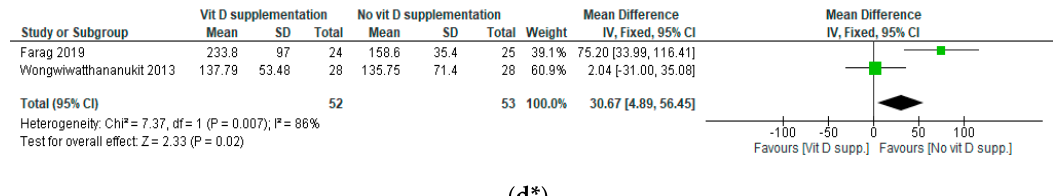
Figure 3. Meta-analysis of effects of low-dose VDS on LDL-C, HDL-C, TC, and TG. Mean differences for each study are represented by squares, and 95% Confidence Intervals are represented by the lines through the squares. The pooled mean differences are represented by diamonds. Between-study heterogeneity was assessed with the use of the I 2 statistic. VDS: Vitamin D Supplementation; LDL-C: Low-density Lipoprotein Cholesterol; HDL-C: High-density Lipoprotein Cholesterol; TC: Total Cholesterol; TG: Triglycerides. ( a ) Forest plot of mean differences in LDL-C (in mg/dL) between subjects receiving low-dose VDS compared with those not receiving VDS. ( b ) Forest plot of mean differences in HDL-C (in mg/dL) between subjects receiving low-dose VDS compared with those not receiving VDS. ( c ) Forest plot of mean differences in TC (in mg/dL) between subjects receiving low- dose VDS compared with those not receiving VDS. ( d ) Forest plot of mean differences in TG (in mg/dL) between subjects receiving low-dose VDS compared with those not receiving VDS. * The study by Makariou et al. [30] was excluded from the primary analysis since the data are reported as median and range. The median cannot be assumed the same as the mean, and the standard deviations cannot be extrapolated from the range since the sample size is small. In addition, the study explicitly reports on the use of median and range when the distribution is skewed. * In the study by Farag et al. [35], TG at baseline was significantly higher in the intervention group compared with the control group.